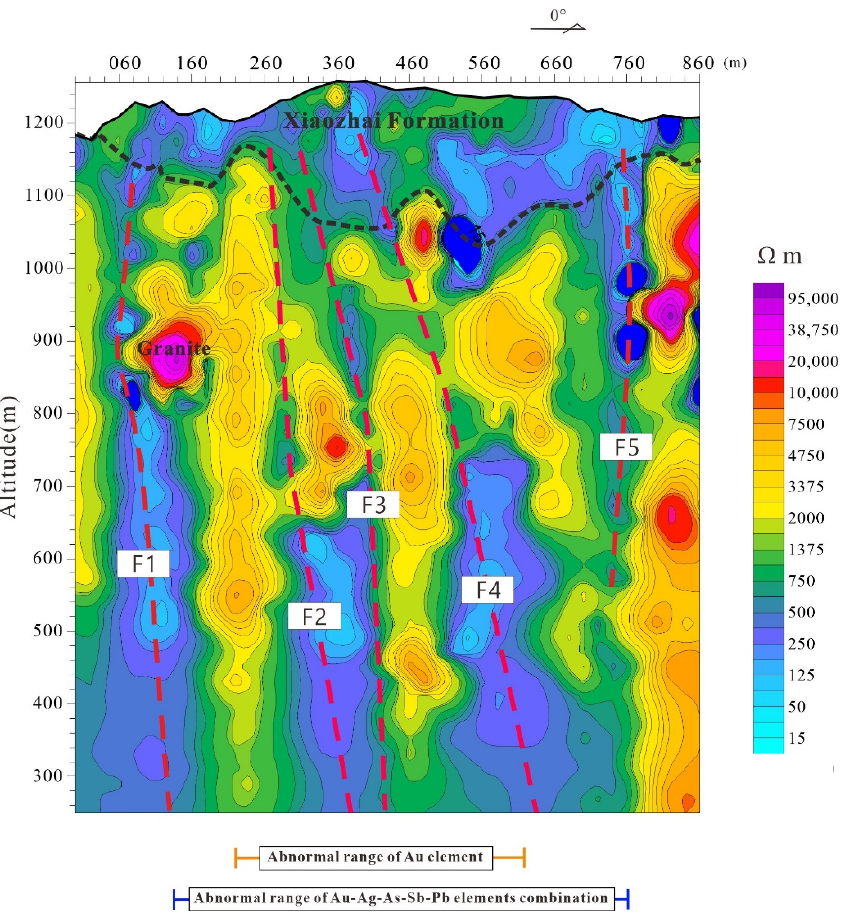
Figure 8. EH4 sounding image of Line DDS1 exploration line in the Dongdashan section of the Jianbeigou gold mine. The dashed line in the profile is the inferred geological boundary between the strata and the granite. The thick dashed red lines are ore-bearing abnormal structural belts.